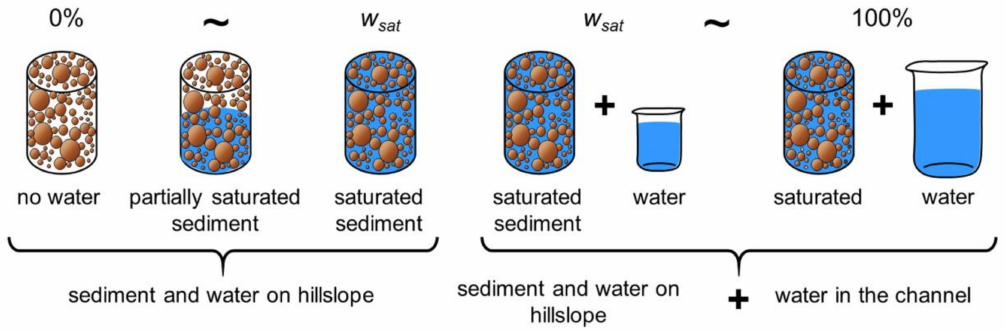
Figure 2. Weight-based water content for the experiment. Below saturation, sediment in the flume is assumed to be sediment and water on hillslope. Above saturation, sediment in the flume is assumed to be sediment and water on hillslope with additional water from the